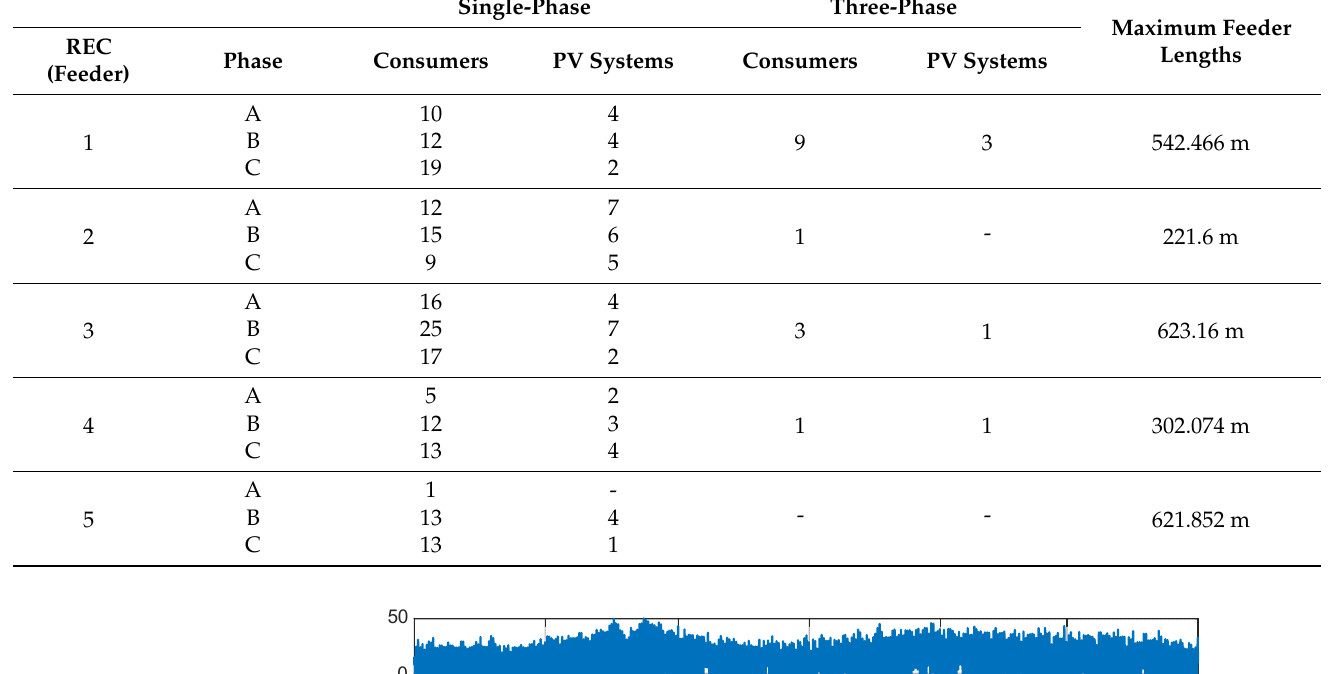
Table 1. Consumers and PV systems connected to the secondary substation LV network. Single-Phase Three-Phase Maximum Feeder LengthsREC